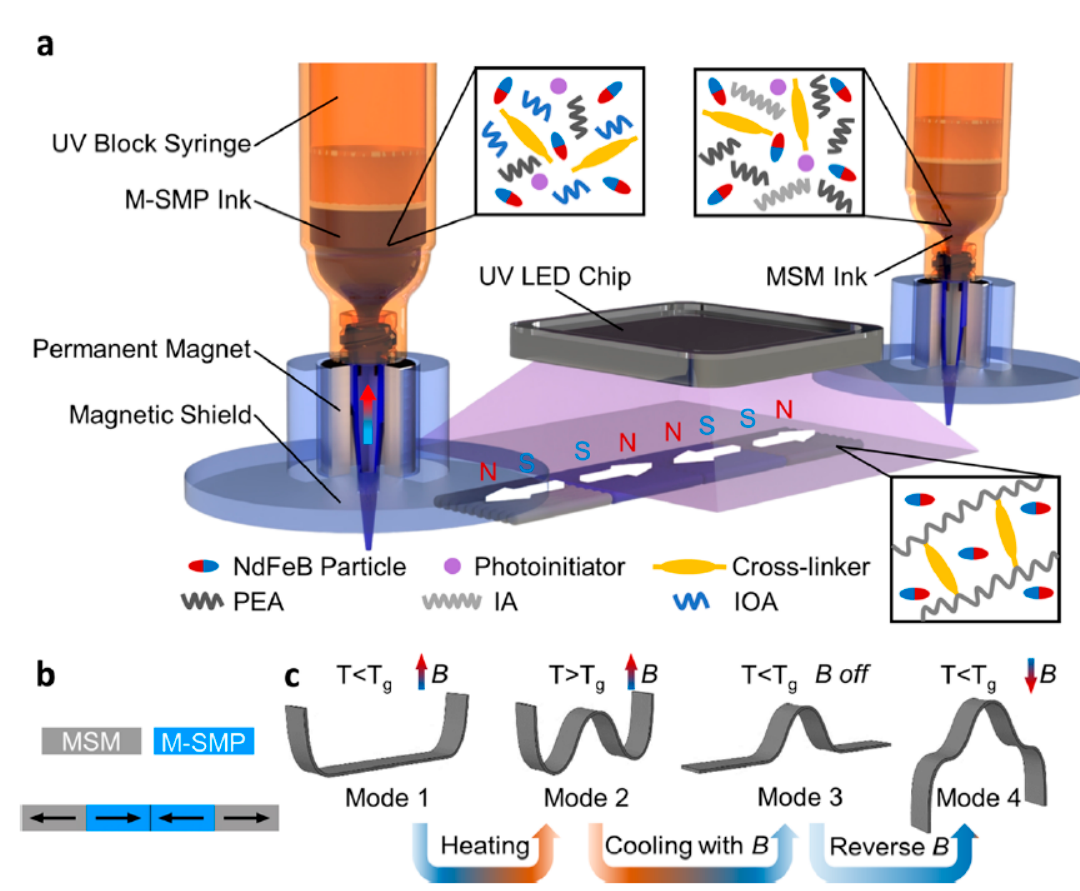
Figure 12. ( a ) The multi-material printing setup with two printer heads for the two different materials. The permanent magnet around the nozzle orients the magnetic particles while printing. ( b ) The pattern printed with the different materials and the directions of the magnetic fields [16] .